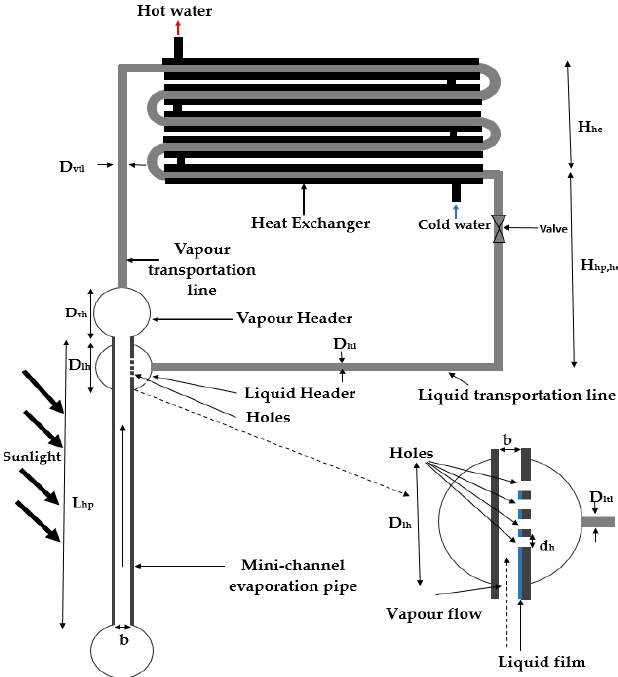
Figure 1. Schematic of the novel solar loop-heat pipe.